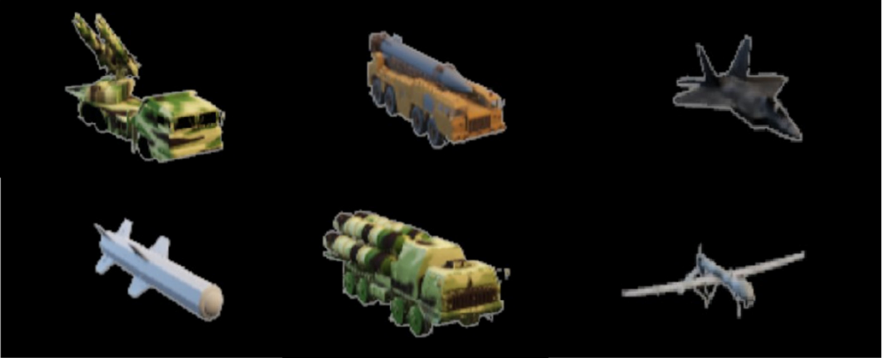
Figure 3. Partial correlation model.